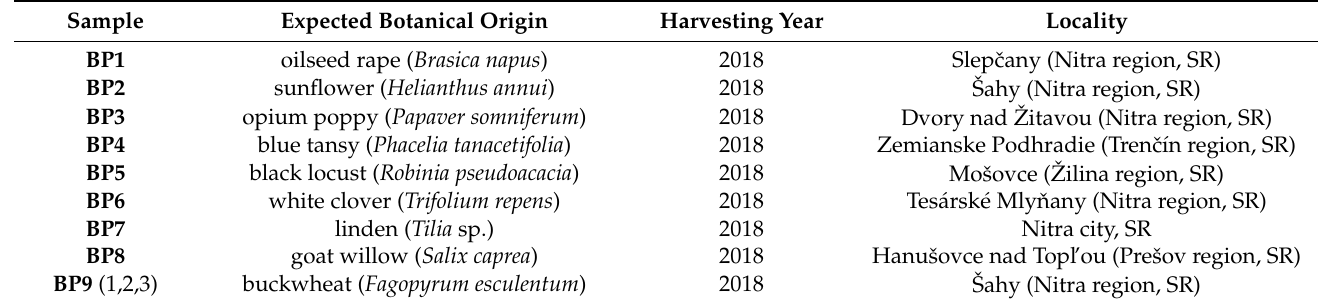
Table 1. Specification of bee pollen